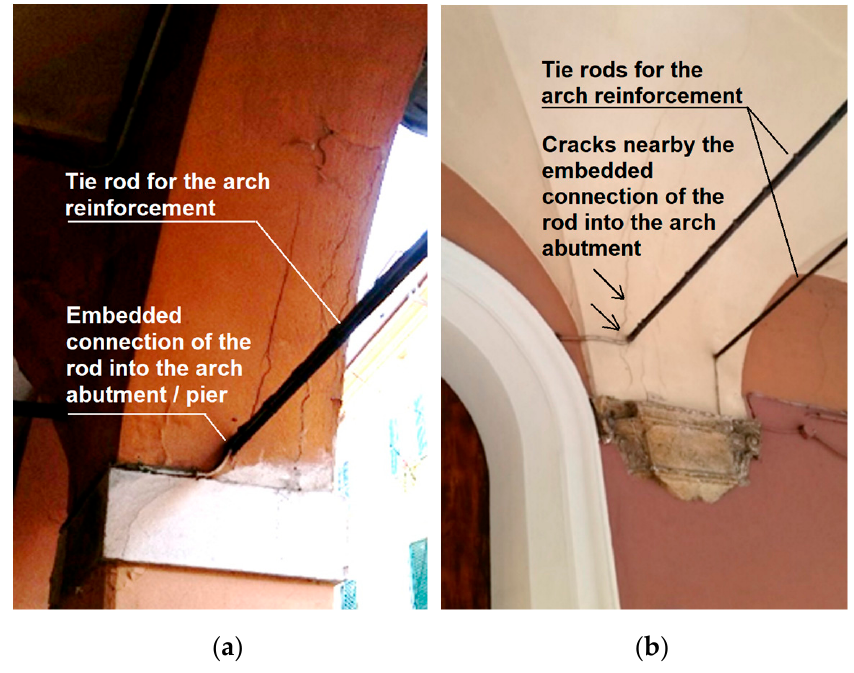
Figure 11. Single ( a ) and double ( b ) steel tie-rods used for arch and vault reinforcement, Bologna, Italy.